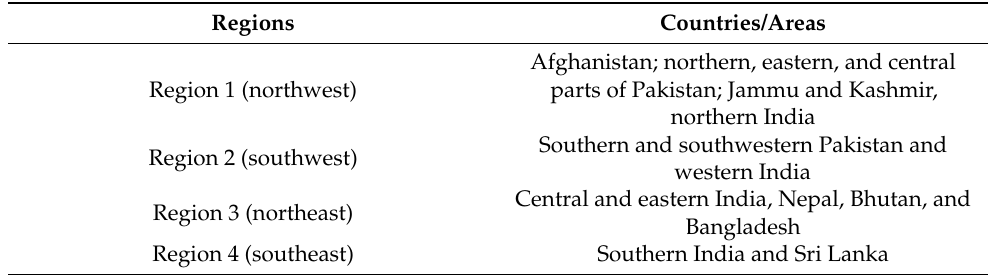
Table 3. Geographical coverage of study region. Regions Countries/Areas Afghanistan; northern, eastern, and central Region 1 (northwest)